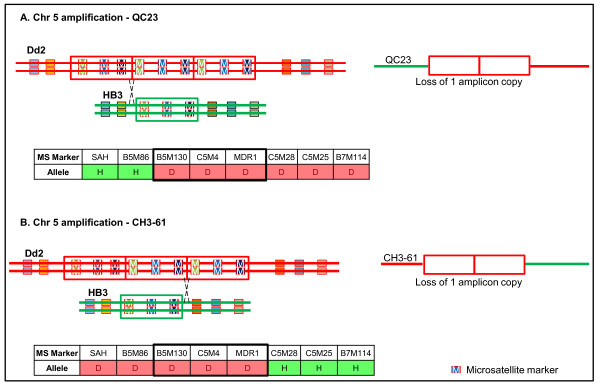
Role of homologous recombination (HR) in copy number fluctuation in the Chr 5 amplification. Linkage analysis of the CNV region revealed that of the progeny strains that exhibited copy number fluctuation at the Chr 5 locus, two CNVs were generated by HR between the two parental homologs. The predicted HR patterns and allele distributions in each progeny line A) QC23 and B) CH3-61, are shown with the associated MS marker. The region of the amplicon is highlighted by a black box, and the three MS markers that overlap with the CNV region are shown within the boxed region. D = Dd2 allele, H = HB3 allele.